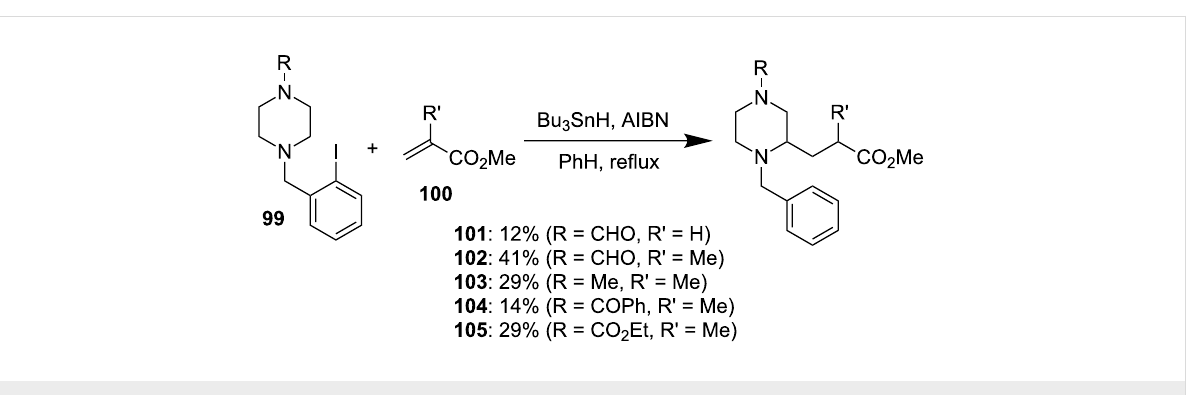
Figure 17: Free radical approach by Undheim et al. in 1994